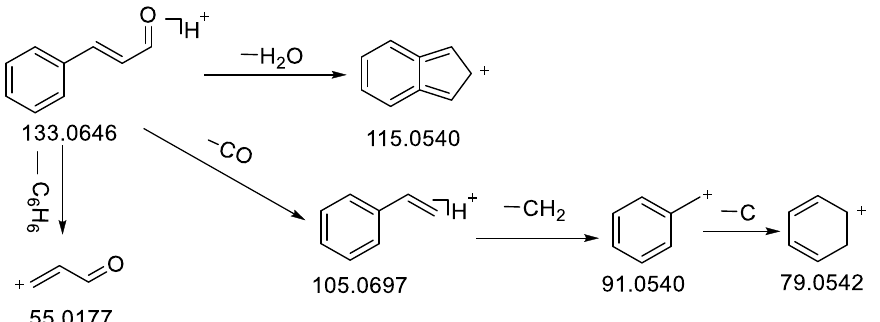
Figure 2. Fragmentation pathway of trans -cinnamaldehyde in positive ion mode.